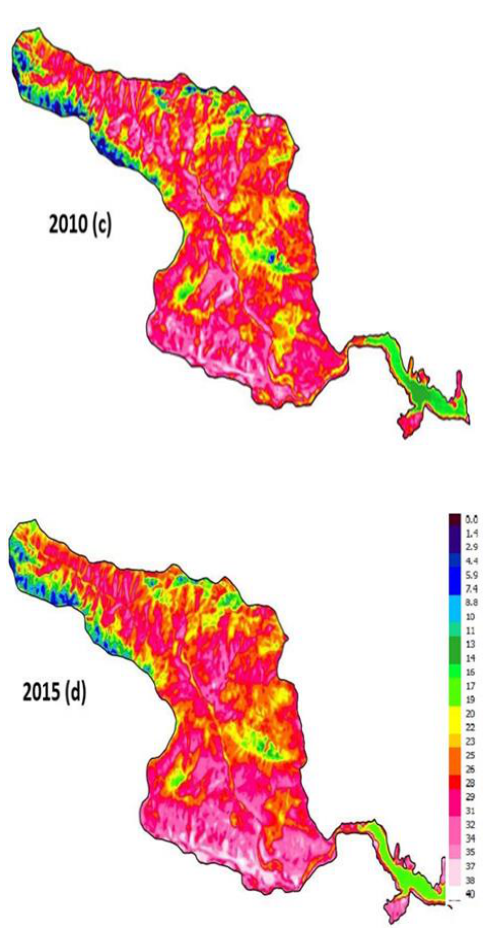
Figure 6. Spatial variation of LST (°C) in 1985(a), 1994(b), 2010(c) and 2015(d)